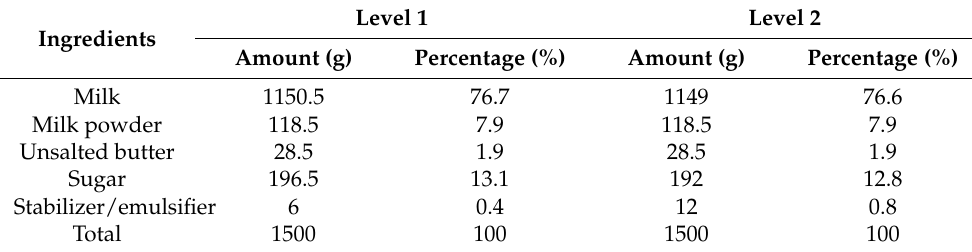
Table 1. Formulation for soft serve ice